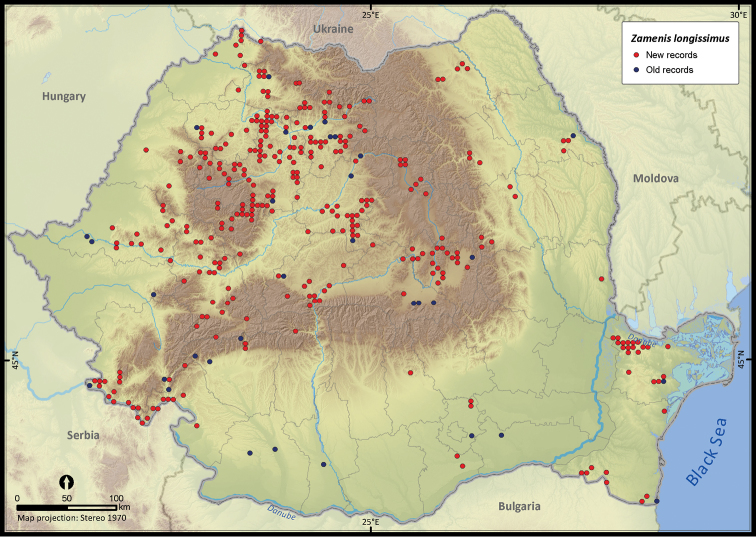
Zamenis longissimus.